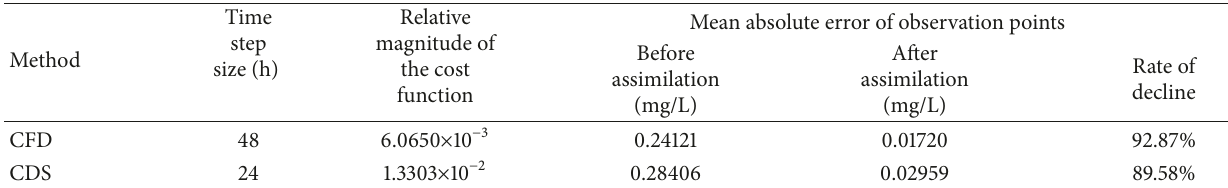
Table 4: The results of the adjoint model using CFD and CDS.